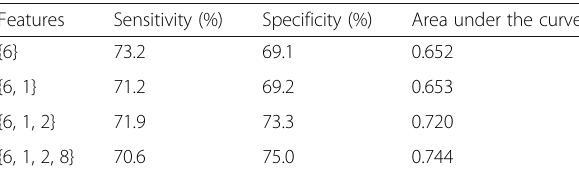
Table 4 Performance of different feature combinations using the random forest method